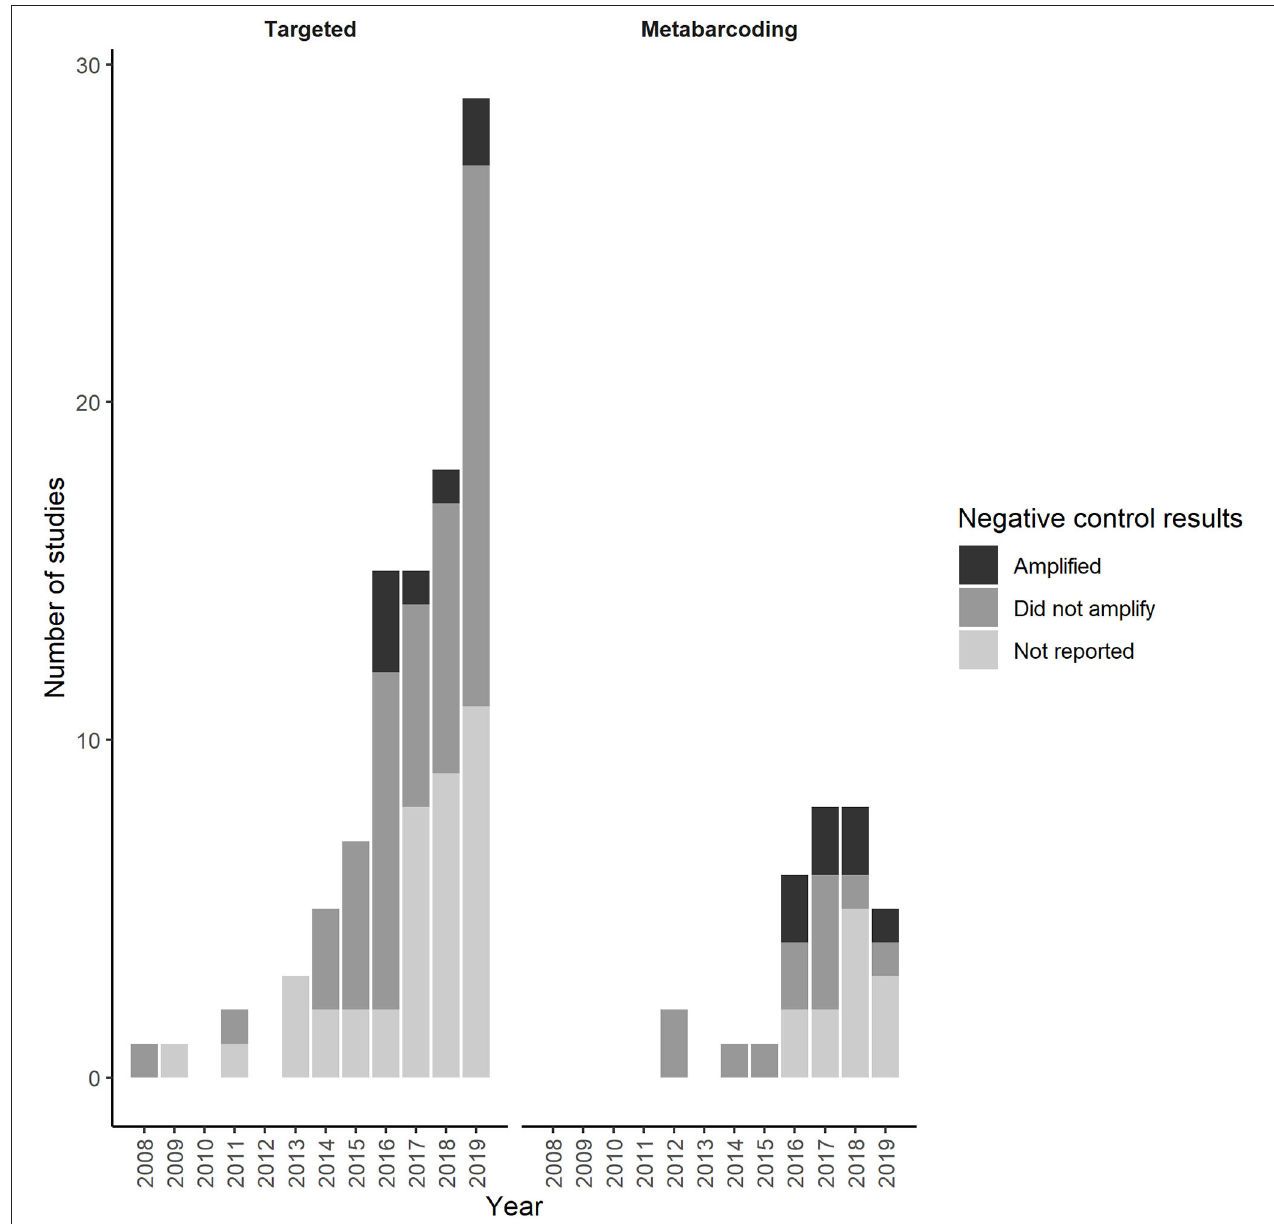
FIGURE 3 | Annual trends in the number of studies in the first literature review that reported amplification of negative controls (Amplified), no amplification of negative controls (Did not amplify), or collected negative controls but did not report amplification results (Not